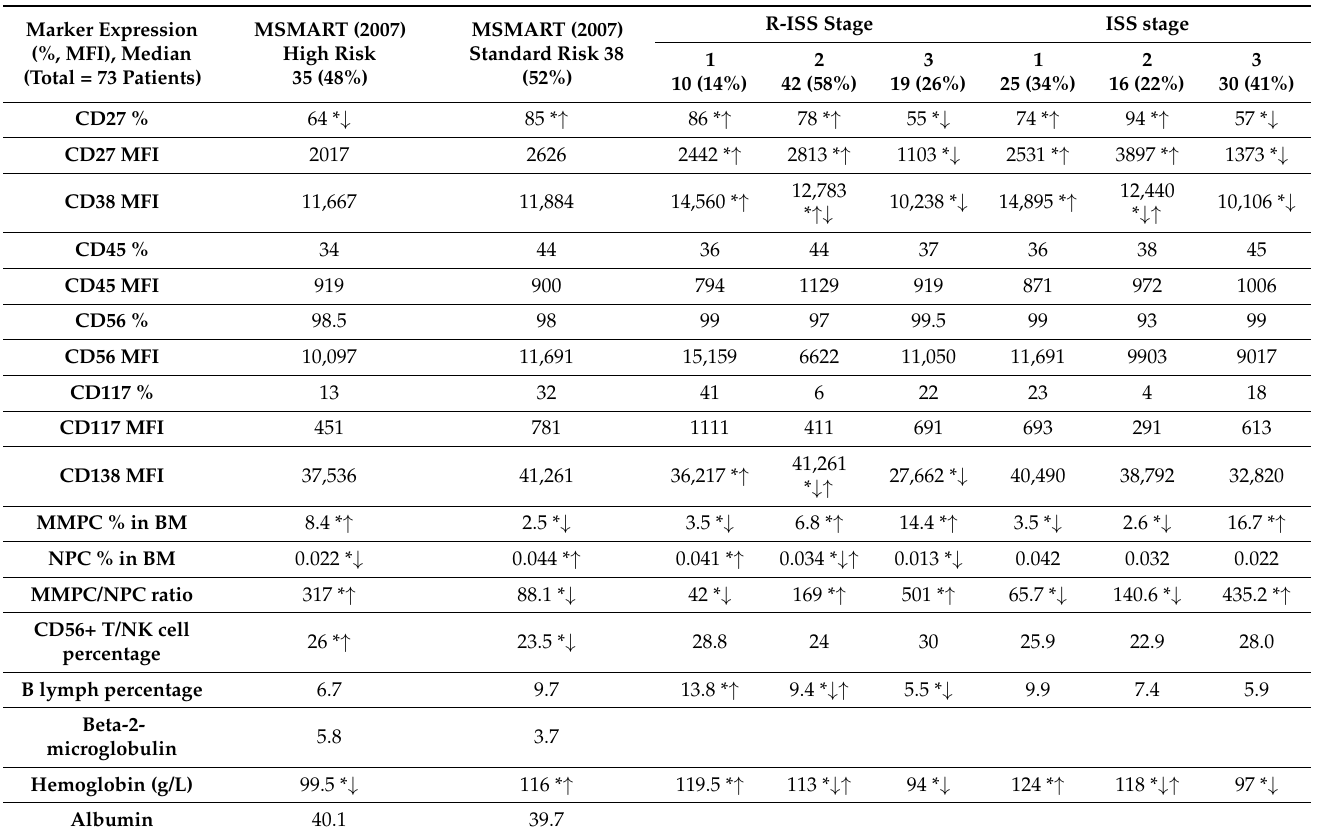
Table 3. Differences in immunophenotype (by MFI or percentage median), cell percentages and laboratory test values between different risk assessment stages. MFI—mean fluorescence intensity, MMPC—malignant plasma cells, NPC—normal plasma cells. Statistically significant ( p < 0.05) differences marked with *; arrow indicates if value is higher or lower than the contrary